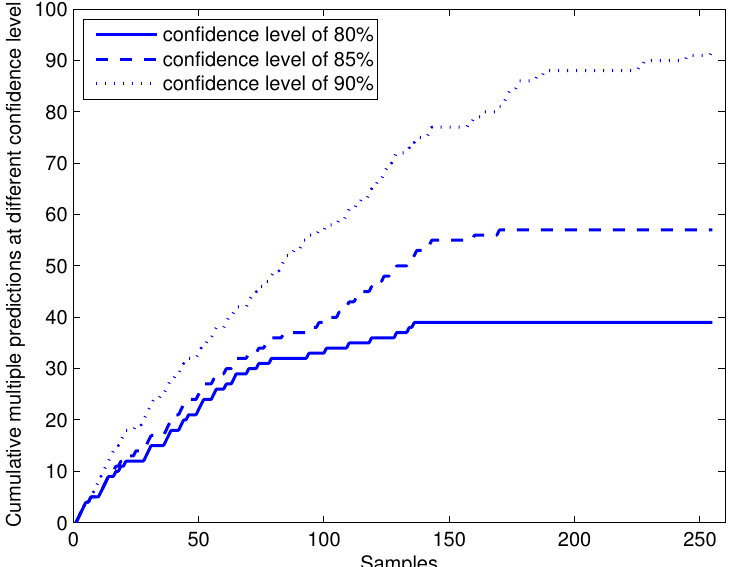
Figure 6. Cumulative multiple predictions of online conformal prediction with CP-1NN at different confidence levels of 80%, 85% and